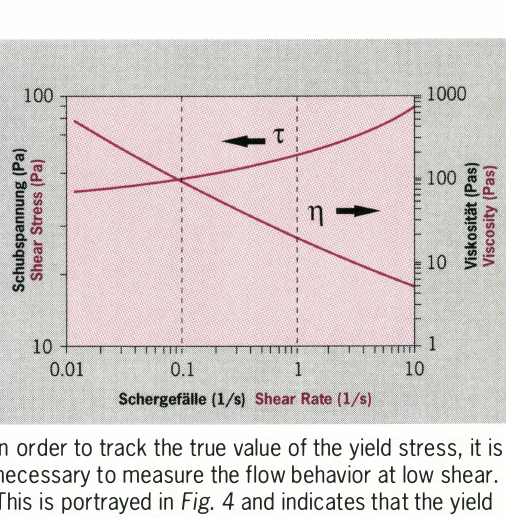
Fig. 4: Low shear flow behav­ iour of the hair gel; the yield stress is 42 Pa